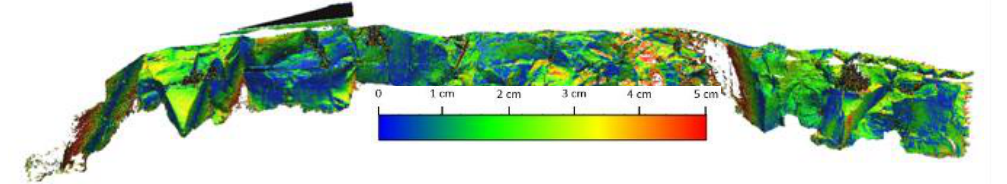
Figure 8. Error mapping of deviation between TSL and model